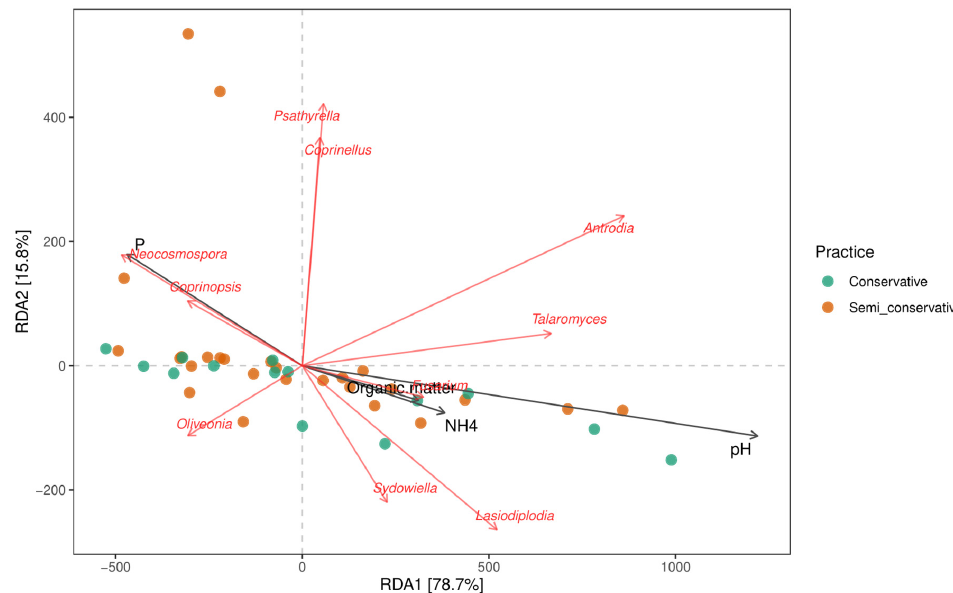
Figure 7. RDA diagram showing the relationship between edaphic properties and fungal com- munity composition in Theobroma cacao under different cultivation practices (conservative and semi-conservative).